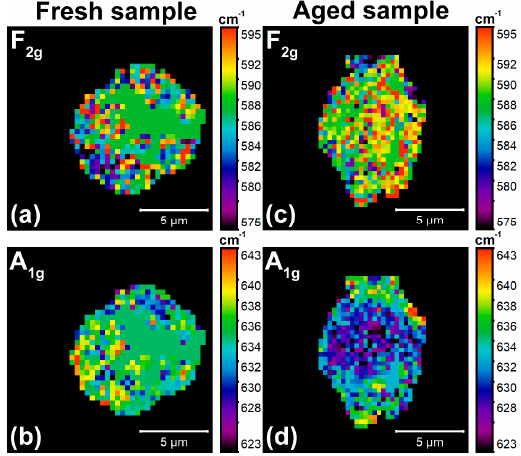
Figure 2. Mapping of the ( a , c ) F 2g , and ( b , d ) A 1g peak positions in the active ionic particles of ( a , b ) fresh and ( c , d ) aged LMO cathodes. Completely lithiated state: Li 0.9 Mn 2 O 4 (0% SOC).